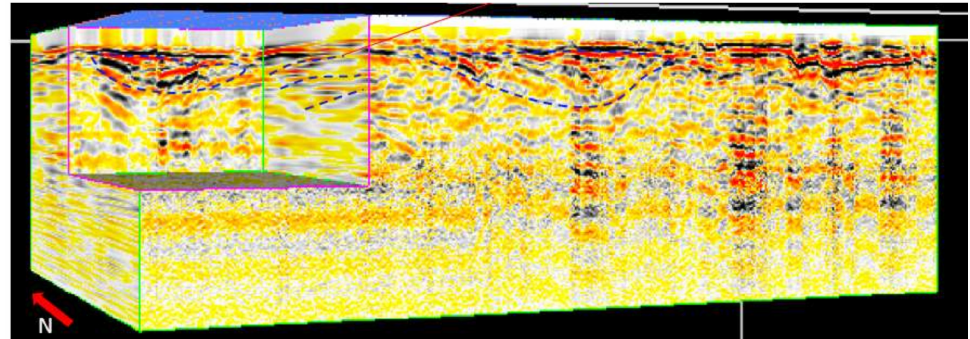
Figure 11. The GPR 3D data with dimensions of 45 × 34 × 10 m. The migrating channels and the forward accretion of the unit bar can be observed. The GPR profile of the bar head reflects the sigmoidal stratification